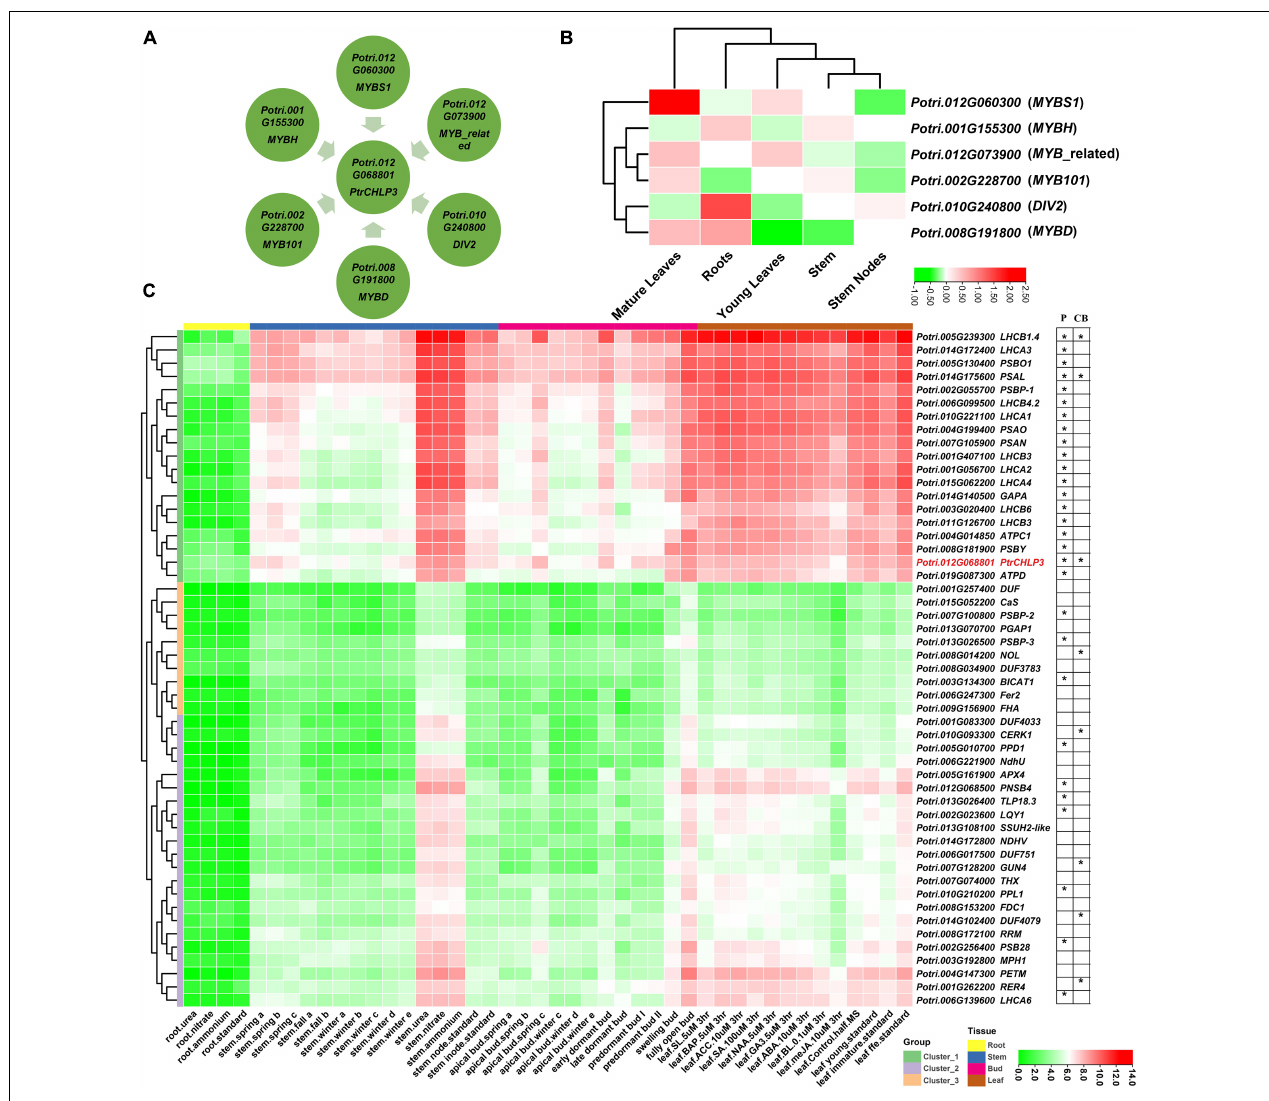
FIGURE 7 | Construction of PtrCHLP3 molecular regulatory network. Bioinformatic analysis of TFs of PtrCHLP3 . (A) Interaction network analysis of TFs- PtrCAX3 . The blue rectangle represents TFs upstream of PtrCHLP3 . (B) Heat maps showing the transcriptional abundance of upstream transcription factors of PtrCHLP3 under different plant tissues. The range of fold change in expression in the heat map is indicated by the color bar. (C) Cluster heat map analysis of genes co-expressed with PtrCHLP3 in different plant tissues and treatments. P, Photosynthesis; CB, Chlorophyll biosynthesis. The asterisk indicates that the gene is involved in the process of P or